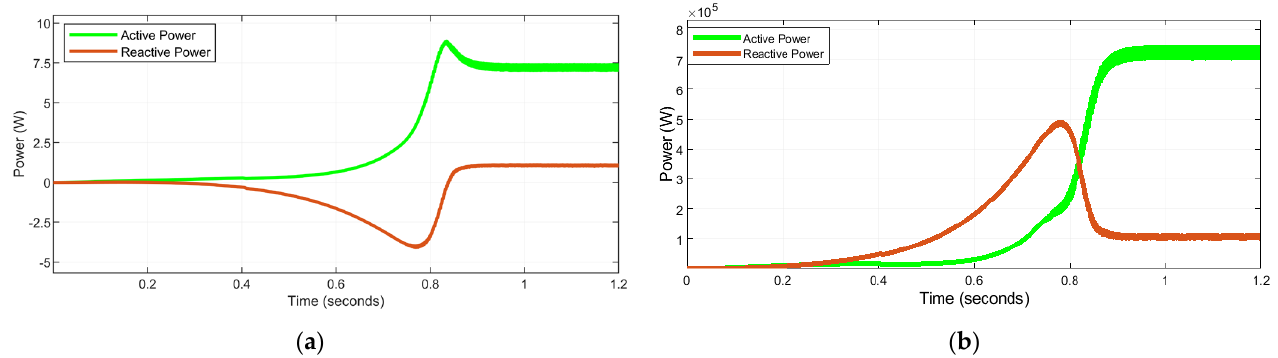
Figure 12. The controller adjusts some parameters and performance to optimize and stabilize the active power and reactive power in a certain bouned range: ( a ) DG1; ( b ) DG2.